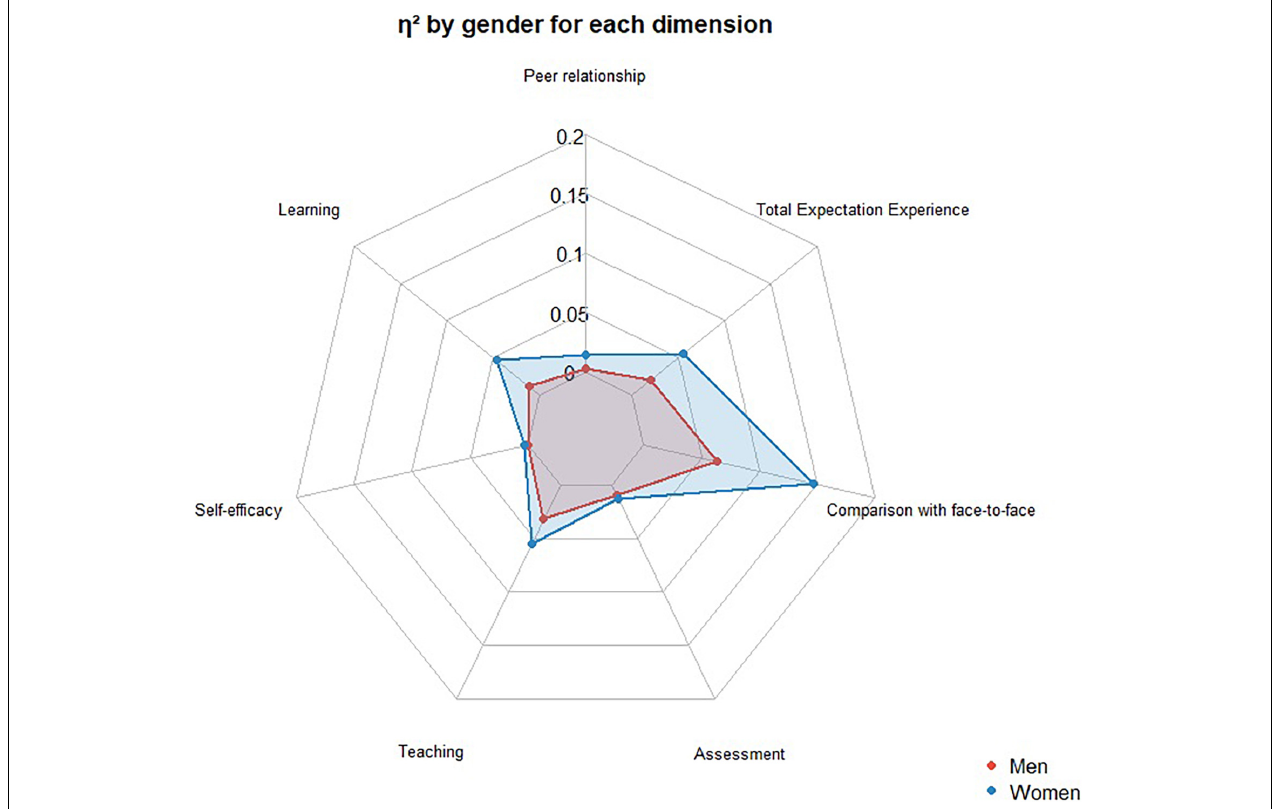
FIGURE 1 | The effect size of the change between expectations and experience according to the gender of the participating